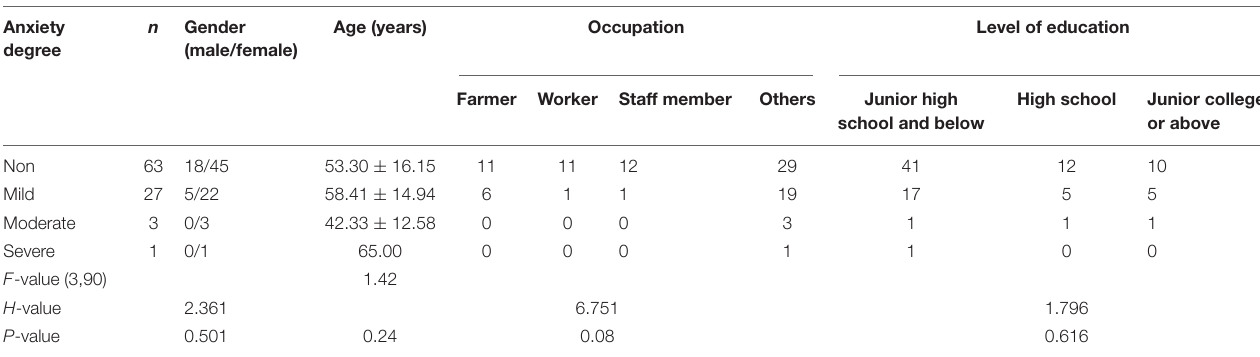
TABLE 1 | General characteristics of DILI patients with